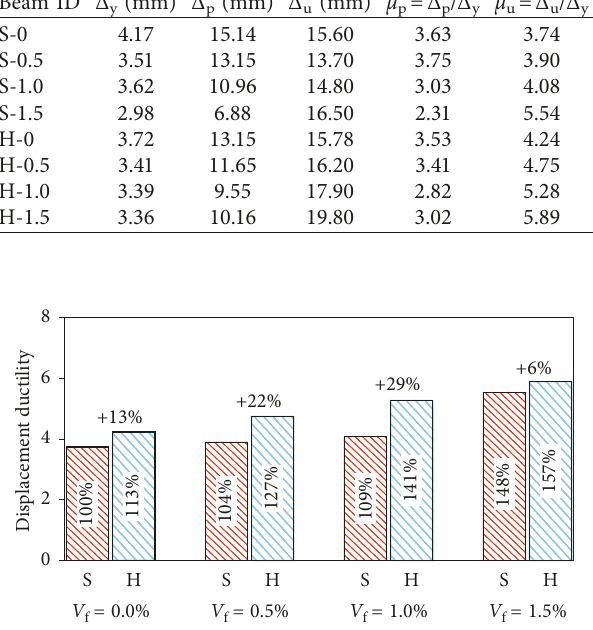
Figure 13: Percentage increase in ductility due to steel fiber